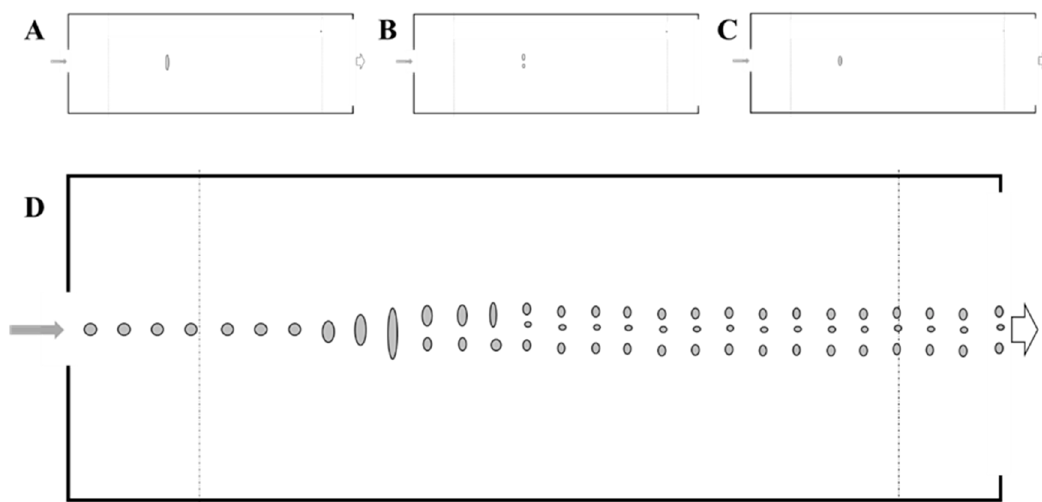
Figure 3. Schematic illustration of a single drop breakup visualization experiment. ( A – C ) Illustration of a sequence of high-speed images of a drop undergoing elongation and breakup. ( D ) Compilation of a large number of such images showing the breakup process.